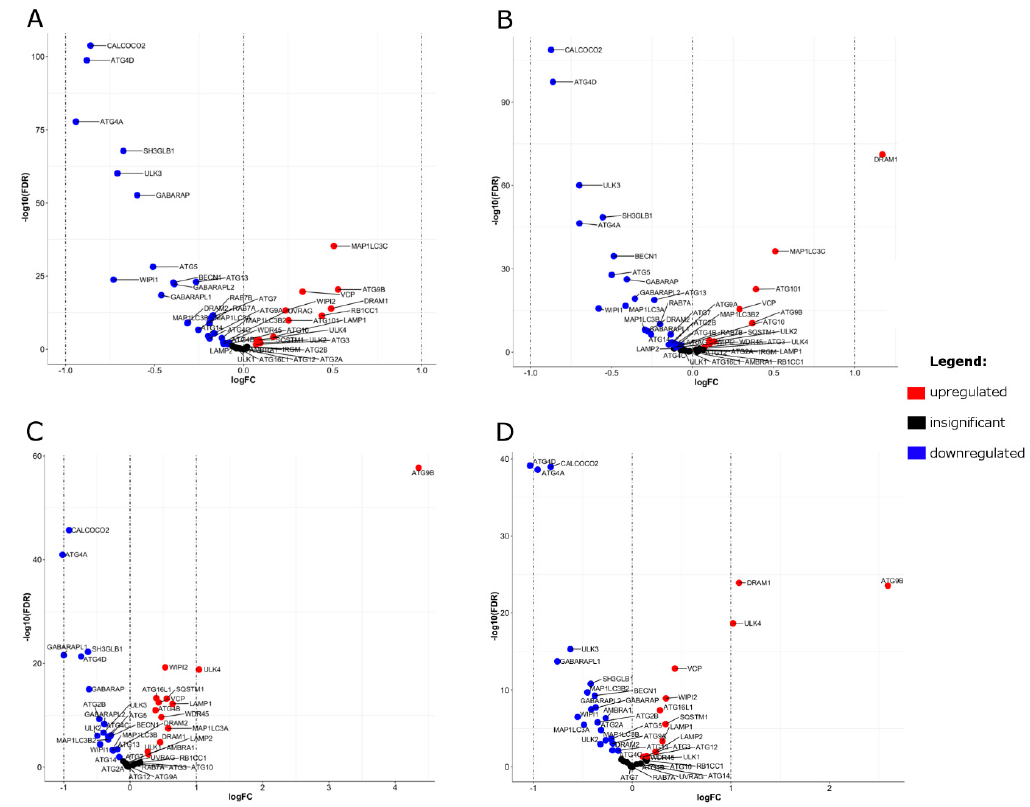
Figure 3. Differential expression (DE) analysis between autophagy-based clusters and normal adjacent tissues. ( A , B ) depict volcano plots based on DE analysis in the ‘limma’ package in CRC array dataset ( A —cluster 1 vs . normal; B —cluster 2 vs . normal). ( C , D ) depicts volcano plots based on DE analysis in the limma package (RNA-seq datasets). ( C —cluster 1 vs . normal; D —cluster 2 vs . normal). The vertical lines correspond to 1.0-fold up and down, respectively. The blue dot in the plot represents the gene with a False Discovery Rate (FDR) ≤ 0.05 and logFC < –1, whereas the red dot represents the gene with a FDR ≤ 0.05 and logFC > 1. Black dots indicate insignificant changes in gene expression. Data used to build volcano plots are included in Supplementary Table S3.